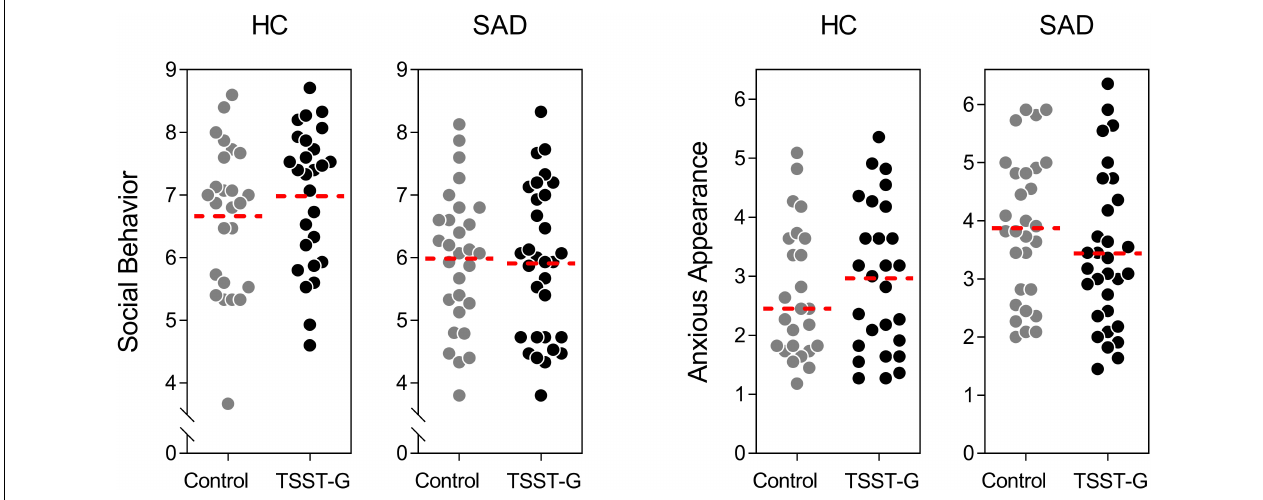
FIGURE 3 | Effects of acute stress on social behavior and anxious appearance during the post-stress conversation for controls and participants with SAD; dots represent individual data, dotted lines represent the